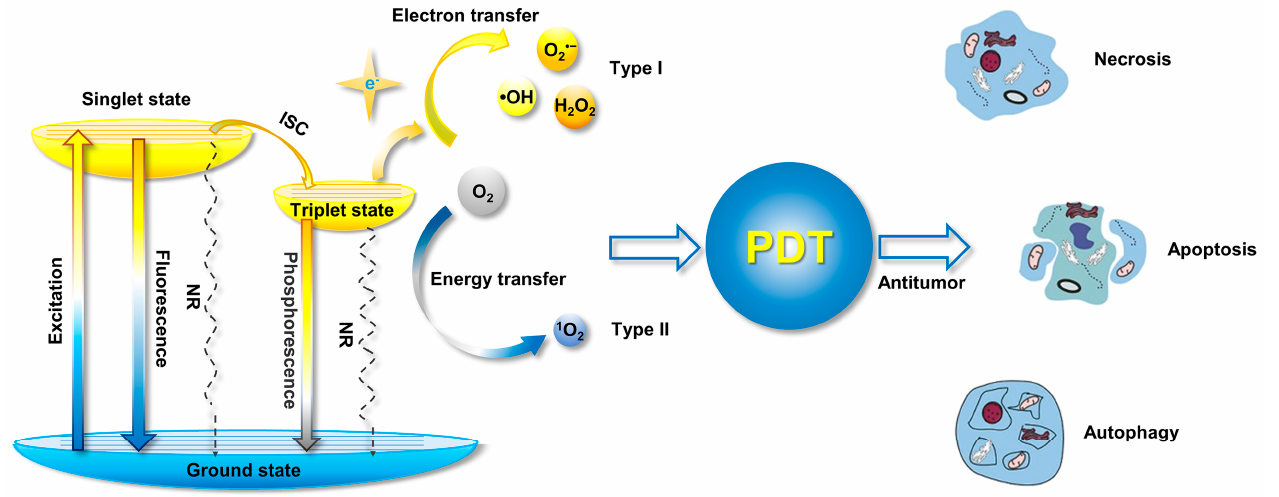
Figure 2. Mechanism of ROS generation form photosensitizer illustrated by Jablonski diagram, and the processes for PDT-induced cell death (NR: nonradiative pathway). Modified with the permission from the authors of [3]. Copyright 2020, the Author(s). Published by